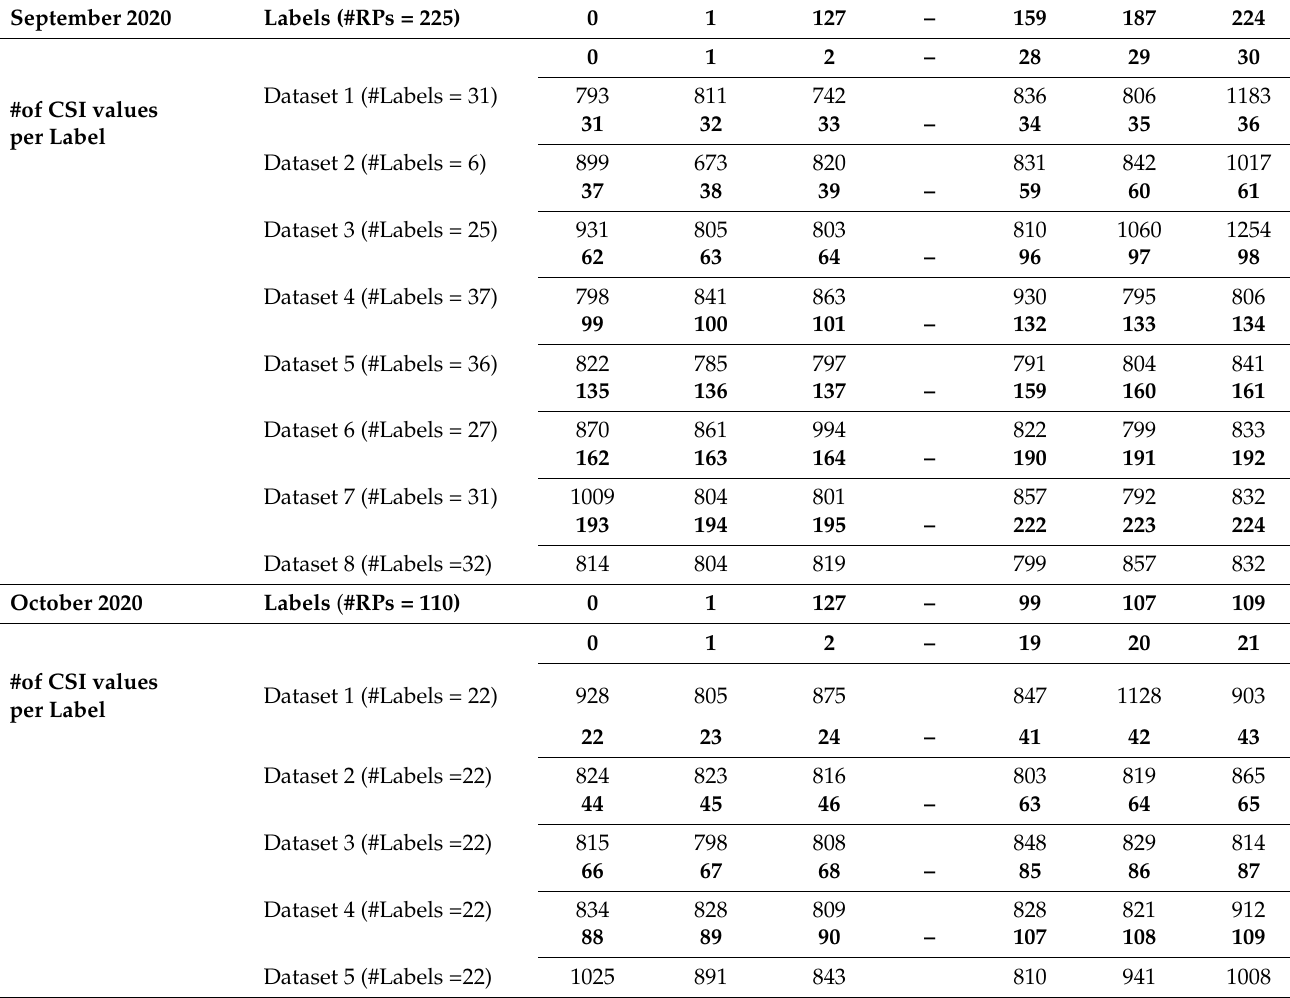
Table 3. Distributions of channel state information measurements per